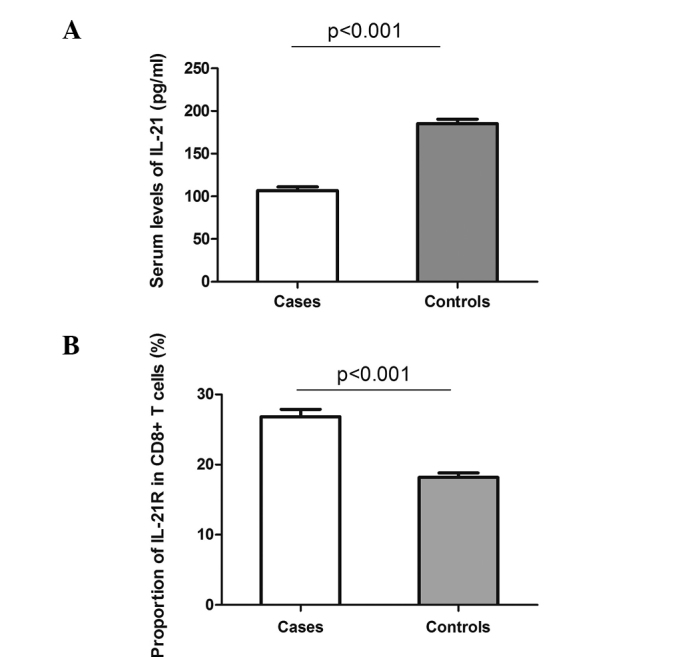
Serum levels of IL-21 and IL-21R expression on peripheral CD8+ T cells were significantly altered in the patients with DLBCL compared with the healthy controls. (A) The serum levels of IL-21 were decreased in the patients compared with the controls. (B) The percentage of IL-21R on the CD8+ T cells was increased in the patients compared with the controls. Data were calculated from 72 patients and 62 healthy controls. P-values are shown. IL-21, interleukin 21; IL-21R, IL-21 receptor; CD8, cluster of differentiation 8; DLBCL, diffuse large B-cell lymphoma.